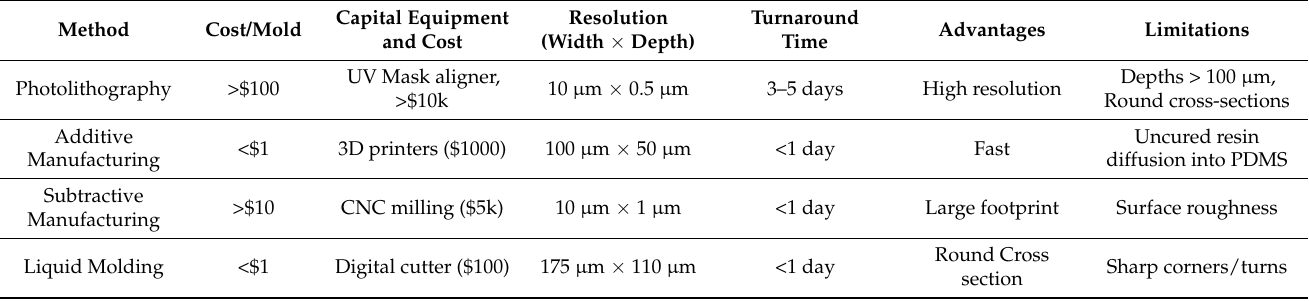
Table 1. Comparison of the proposed liquid micromolding with other microfluidic prototyping